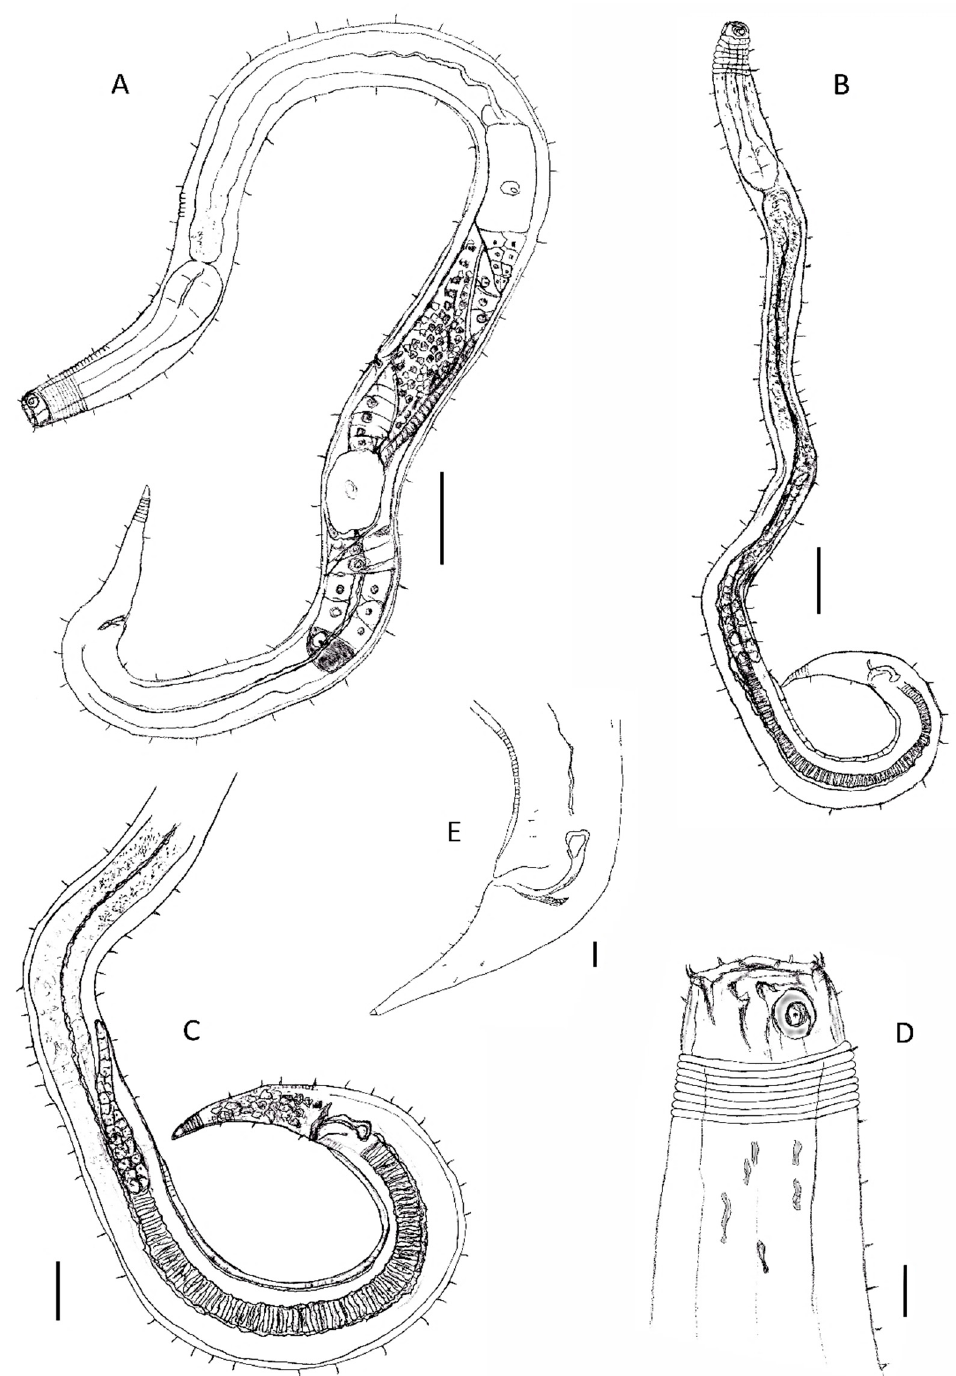
Figure 4. ( A ) female: overview of female body with details on the didelphic–amphidelphic repro- ductive system with reflexed ovaries; ( B ) male: overview of male body; ( C ) detail of the monorchic reproductive system with one anterior outstretched testis D detail on the head region (teeth and amphidial fovea); ( A – C )—scale 50 μ m; and ( D , E )—scale 10 μ m .